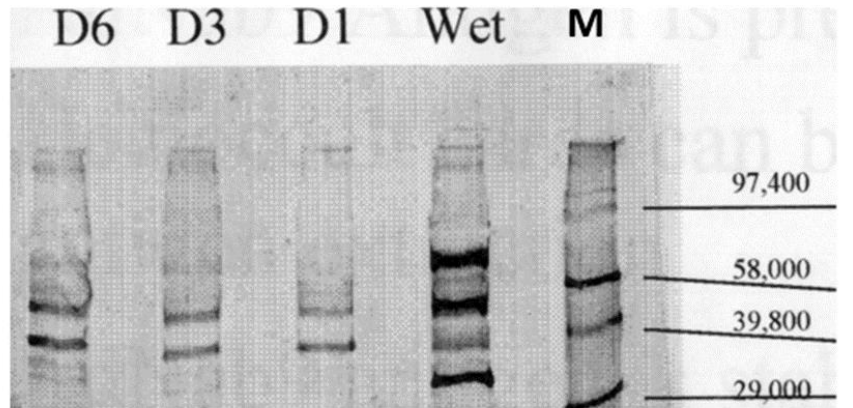
Figure 12. Western blot of stool with specific p87 bands and Molecular Weight Markers. Monoclonal antibody Adnab-9 that recognized p87 reacted in a Western blot of fecal samples. The blot showed positive bands with the relative mobility (M) molecular weight standards designated on the right. “Wet” represented a sample that had been freshly obtained and processed less than 24 h, being left at room temperature. D1, D3, and D6 were the sample stored at room temperatures for 1, 3, and 6 days, respectively. Paradoxically, while D6 appeared to have stronger bands, as compared to D1 and D3, the conditions of prolonged changes in the temperature and humidity could have caused these changes in the protein bands.